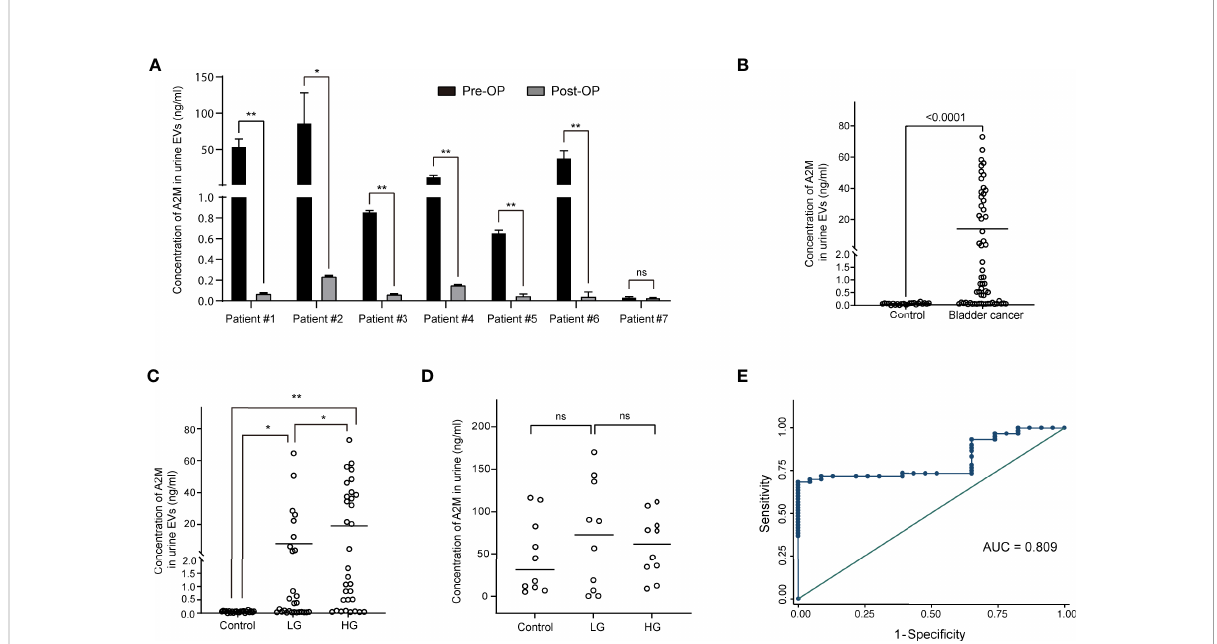
FIGURE 5 Clinical validation of a2M as a bladder cancer biomarker. After separating EVs from urine using ExoDisc, EVs (0.5 µg per sample) were subjected to ELISA for a2M. (A) Pre- and post-operative changes in urine EV a2M levels from seven individual cancer patients. a2M levels in urinary EVs were analyzed via ELISA before and after surgery in randomly selected bladder cancer patients. Paired sample t-test, * p <0.05, ** p <0.01, ns: not signi fi cant. (B) Quanti fi cation of a2M in urinary EVs from non-cancer controls (N=23) and bladder cancer patients (N=60). Student ’ s t-test. ** p <0.01. (C) Analysis for a2M in urinary EVs from non-cancer controls (N=23), patients with low-grade bladder cancer (N=28), and patients with high-grade bladder cancer (N=32). One-way ANOVA test. * p <0.05, ** p <0.01. (D) Analysis for a2M in urine from non-cancer controls (N=10), low-grade (N=10), and high-grade bladder cancer patients (N=10). One-way ANOVA test. ns: not signi fi cant. (E) ROC curve analysis for the discrimination between BC patients and non- cancer controls based on uEV a2M expression levels as per ELISA. Area under ROC curve =